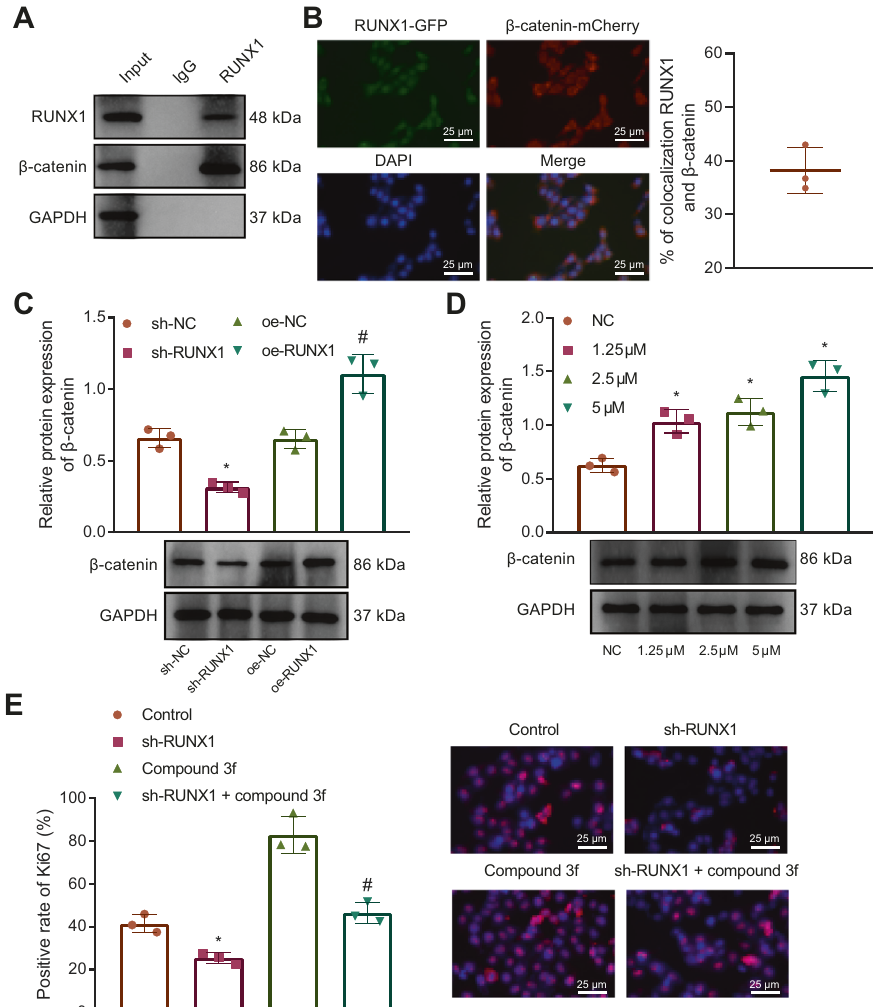
Fig. 4 RUNX1 activates the Wnt/ β -catenin signaling pathway to promote the proliferation of NSCs. A The binding of RUNX1 to β -catenin detected by Co-IP assay. B The co-localization of RUNX1 to β -catenin detected by immuno fl uorescence assay (bar = 25 μ m); RUNX1-GFP: green fl uorescence, β -catenin-mCherry: red fl uorescence, DAPI: blue fl uorescence. C The effect of RUNX1 overexpression/knockdown on the protein expression of β -catenin detected by Western blot analysis. D The protein expression of β -catenin under treatment of the Wnt/ β -catenin signaling pathway activator compound 3 f at different concentrations detected by Western blot analysis. E The effect of RUNX1 overexpression/knockdown on the protein expression of proliferation factor Ki67 in NSCs detected by IHC staining (bar = 25 μ m); PI: the nucleus in red fl uorescence, Ki67: green fl uorescence. * p < 0.05 vs. the sh-NC/NC/control group; # p < 0.05 vs. the oe-NC/sh-RUNX1 group. The cell experiment was repeated 3 times